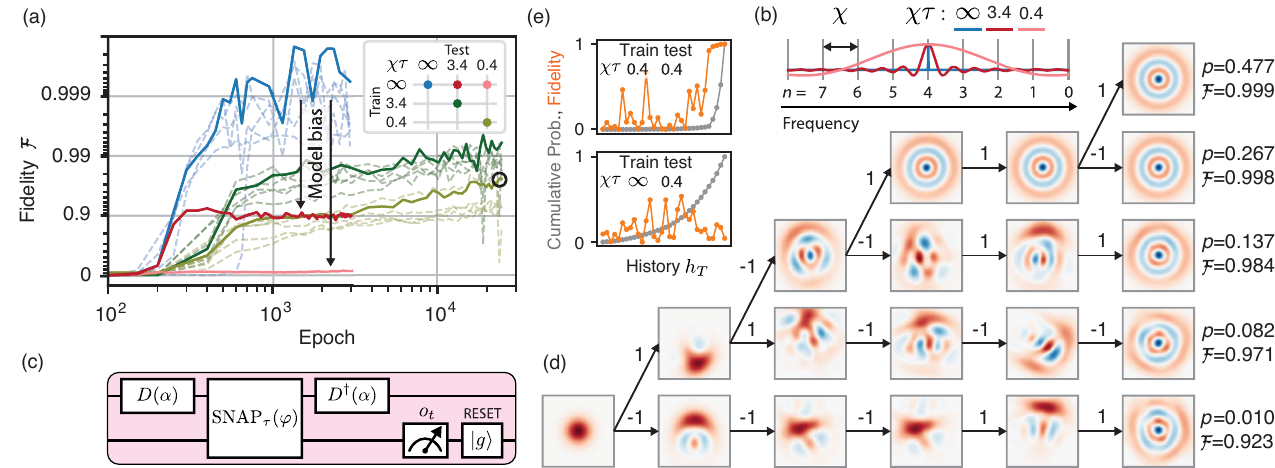
FIG. 5. Learning adaptive measurement-based quantum feedback for preparation of Fock state j 3 i with imperfect controls. (a) Evaluation of the training progress. Blue lines: training the agent with the unitary control circuit, shown in Fig. 2(a), that uses an ideal SNAP. The background trajectories correspond to six random seeds. The protocols of the best-performing seed are then tested using the same control circuit but with a finite-duration gate SNAP τ substituted instead of an ideal SNAP. Such a test reveals the degradation of performance (red and pink lines) due to the model bias. (b) Spectrum of partially selective qubit pulses used in the gate SNAP τ . The degradation of performance in panel (a) occurs because the pulse overlaps in the frequency domain with unintended number-split qubit transitions, leaving the qubit and oscillator entangled after the gate. (c) Feedback-based control circuit containing a finite-duration gate SNAP τ and a verification measurement that produces an observation o and disentangles the qubit and oscillator. The qubit is always t reset to j g i after the measurement. This control circuit requires either postselection or adaptive control. The agent successfully learns measurement-based feedback control (a, green) even in the extreme case χτ ¼ 0 . 4 far from the theoretically optimal regime χτ ≫ 1 . (d) Example state evolution under the policy obtained after 25,000 epochs of training, shown with a black circle in panel (a). The agent chooses to focus on a small number of branches and to ensure that they lead to high-fidelity states. (e) Cumulative probability and fidelity of the observed histories quantifying this trend (top panel). The policy trained with ideal SNAP and tested with SNAP τ (bottom panel) has relatively uniform probability of all histories and poor decision tree, equivalent to 2 T − 1 distinct parameter settings